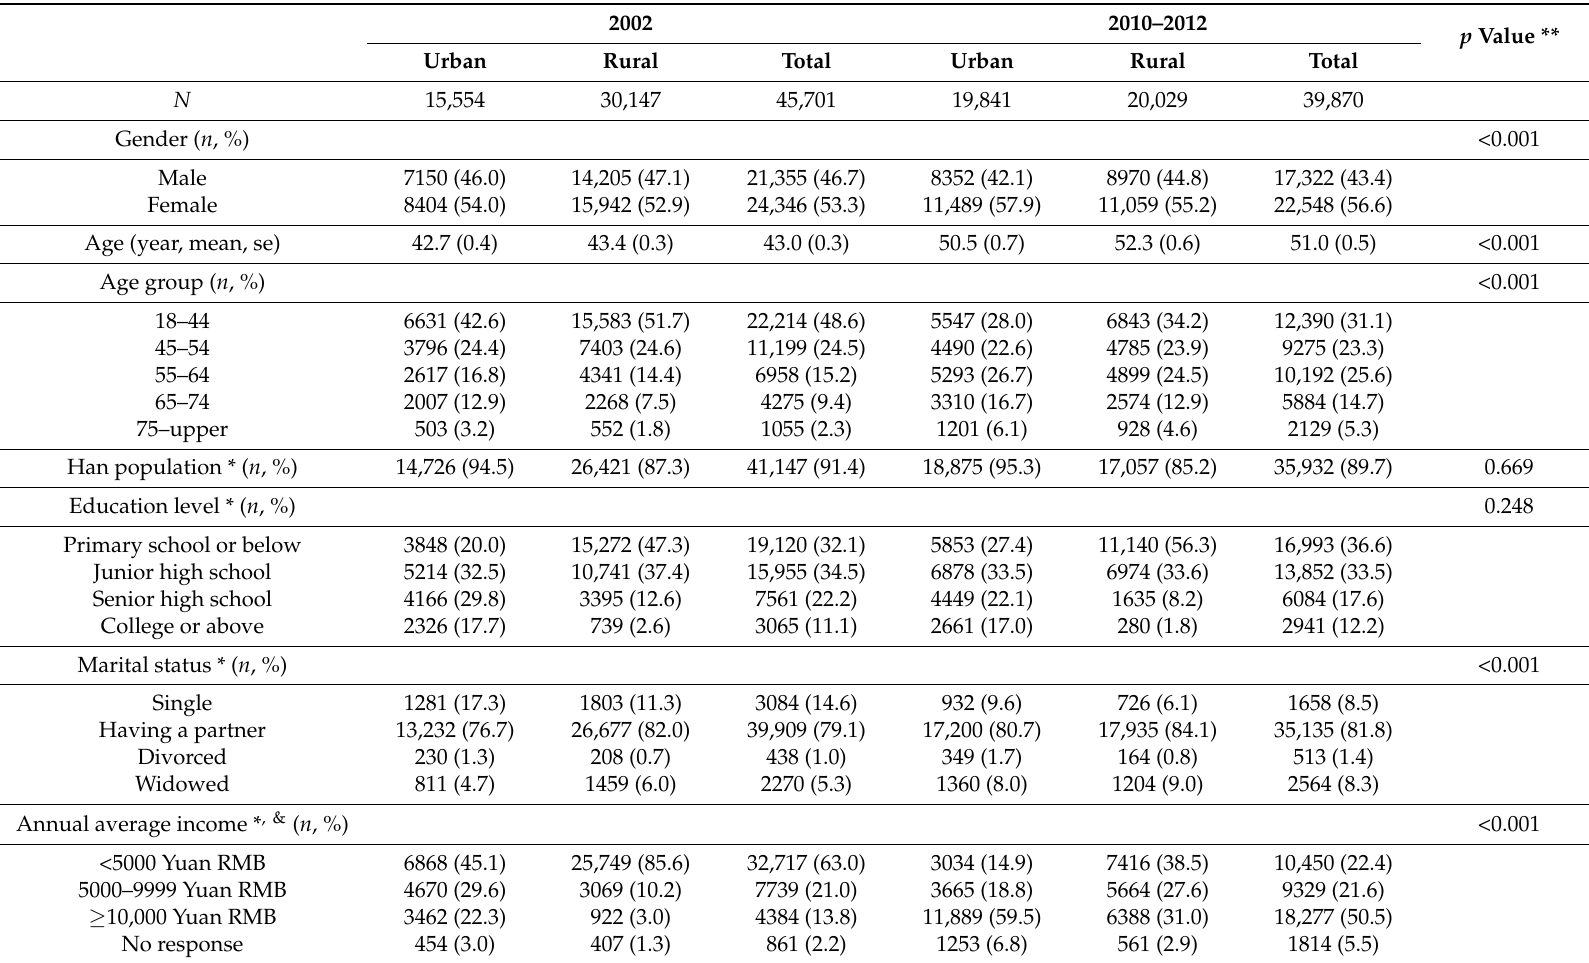
Table 1. Demographic characteristics of participants between the two